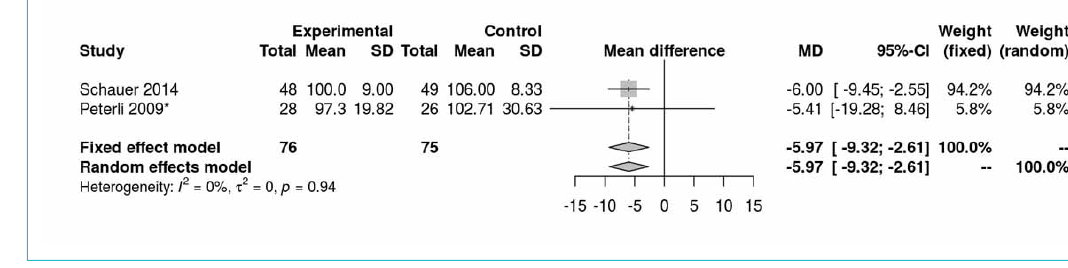
Figure 7d: Glycated haemoglobin (HbA1c) at 12 months (analysis of studies including only patients with type 2